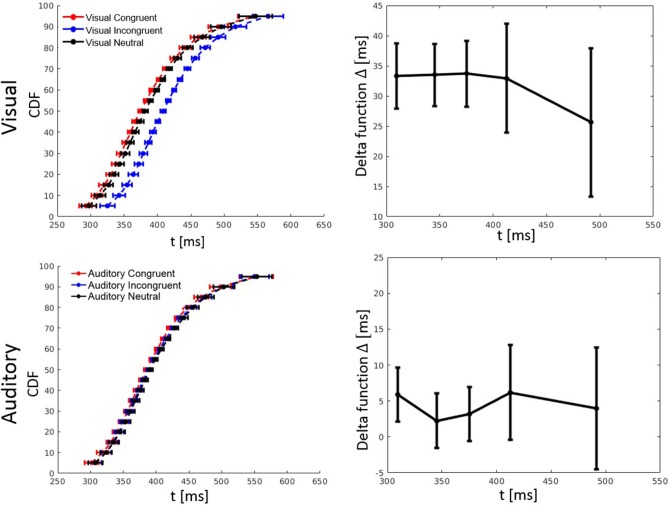
Cumulative distribution functions (CDFs) and delta (Δ) functions for percentiles (5, 10, 15, …, 95%) in Experiment 2. Error bars show 95% confidence intervals and are calculated according to Morey (2008). Each of the visual (auditory) CDFs was calculated as the average over all auditory (visual) congruency conditions. For example, the visual congruent CDF is the average of CVCA, CVNA, and CVIA conditions. Delta functions show the difference between the congruent and incongruent CDFs as a function of response time.